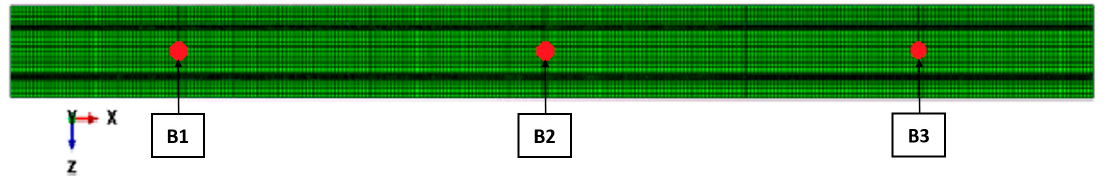
Figure 11. Location of points on the deck of the three-span beam footbridge selected for the analysis of dynamic performance under human movement: B1, B2, and B3.